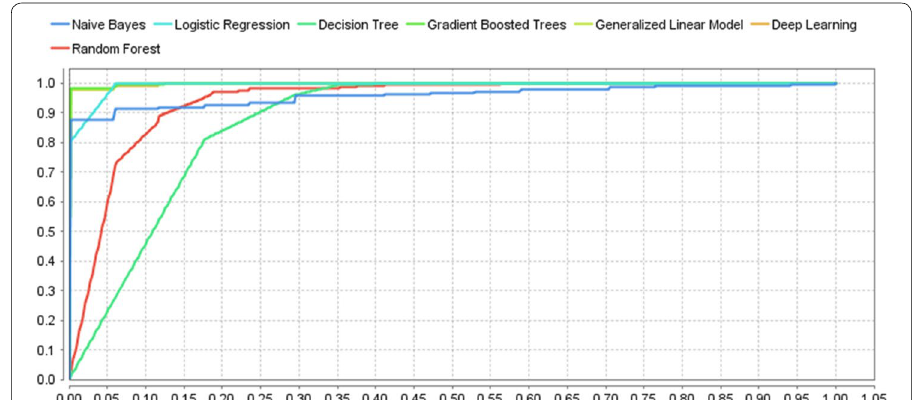
Fig. 6 ROC curve of the incorporated prediction modules